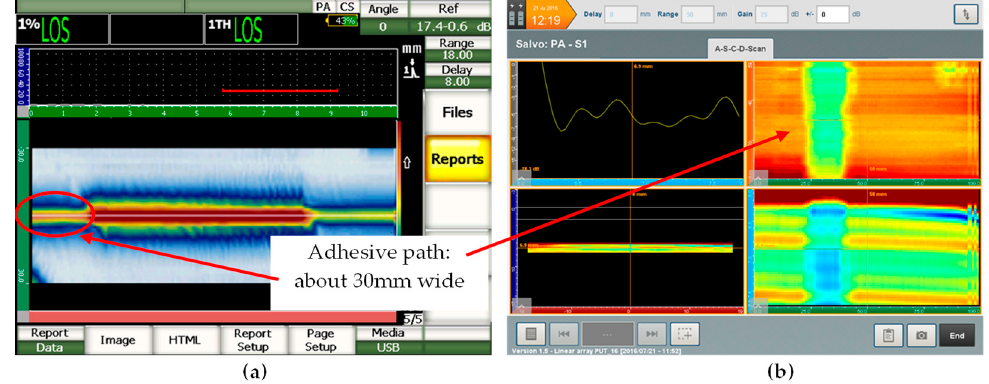
Figure 14. Ultrasonic test results: number of impulses—test from steel ( left side); number of impulses—test from glass ( right side); the di ff erence in the amplitude between the first and the third impulse ( UT S )—test from the steel ( left side); the di ff erence in the amplitude between the first and the third impulse ( UT G )—test from the glass ( right side).